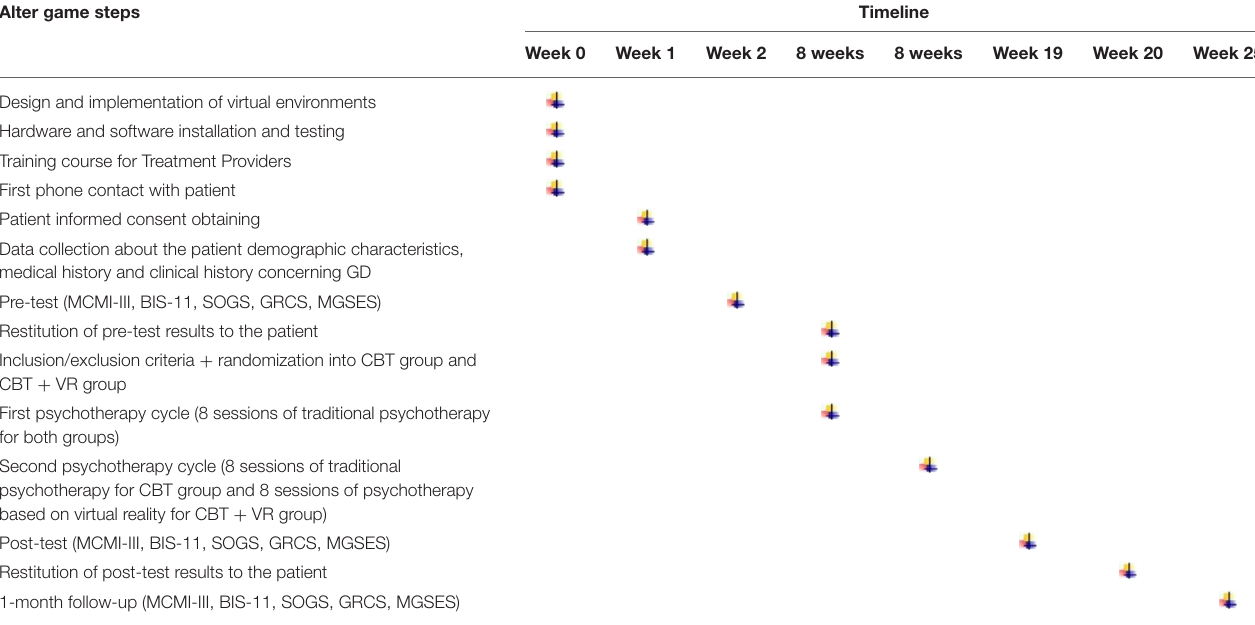
TABLE 1 | Flowchart of Alter Game